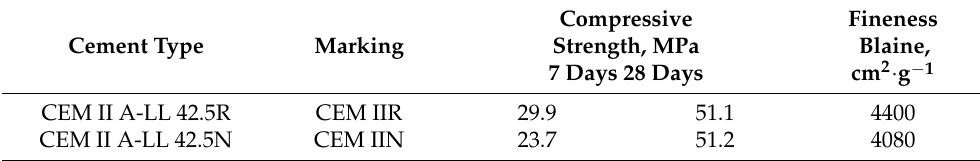
Table 1. Properties of cement.